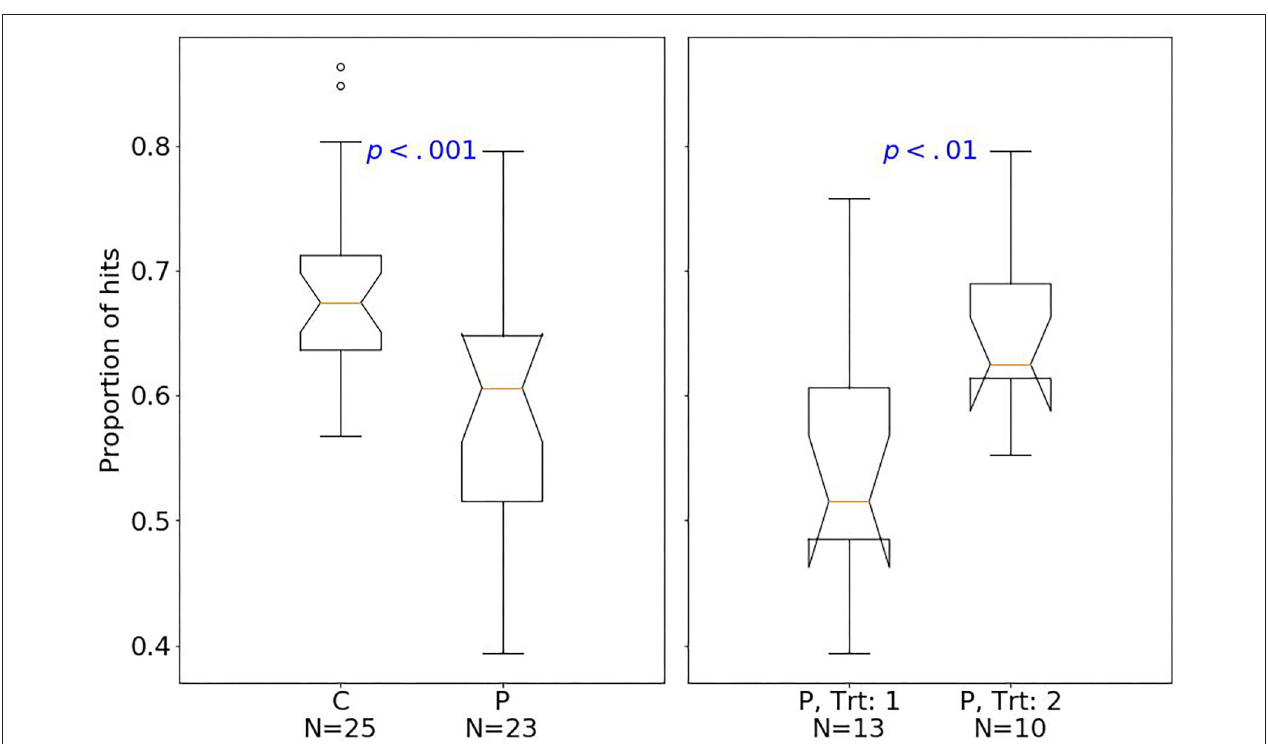
FIGURE 5 | Box plots of the PRL task. The horizontal line represents the median; the boxes extend to the first and third quartile, while whiskers extend to the max/min or the corresponding quartile + 1.5 IQR. C, healthy controls; P, patients with MUD; Trt_1, successful treatment outcome; Trt_2, unsuccessful treatment outcome. Box plots of proportion of hits.